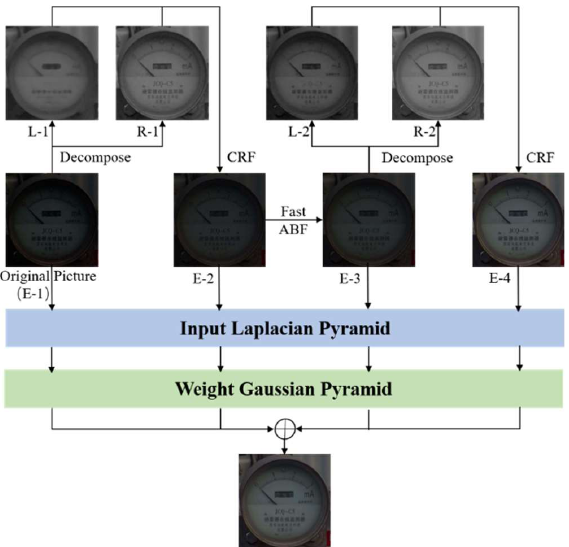
Figure 5. Schematic diagram of image enhancement fusion algorithm.